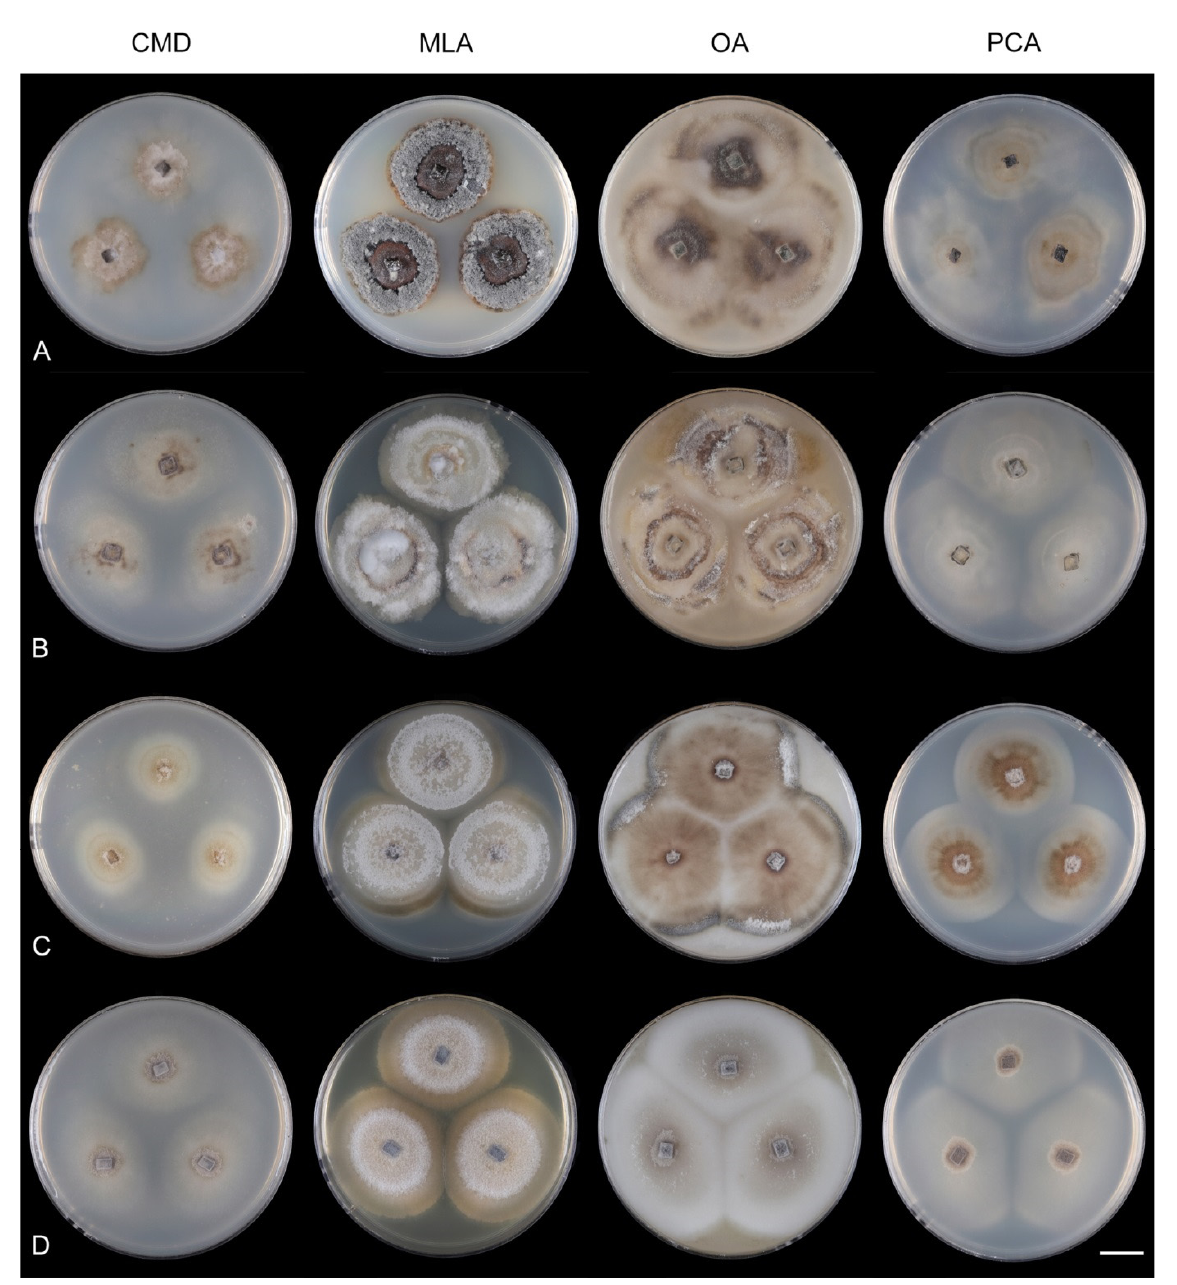
Figure 22. Colony morphology of Codinaeella spp. after 4 weeks. ( A ) Ca. filamentosa CBS 147265 ( B ) Ca. lambertiae CBS 143419 ex-type ( C ) Ca. mimusopis CBS 143435 ex-type ( D ) Ca. pini CBS 138866 ex-type. Scale bar: ( A – D ) 1 cm. Culture characteristics: On CMD: colonies 35–38 mm diam, circular, flat, margin entire, velvety, later mucoid and smooth, whitish-brown, beige toward the margin, reverse beige with a dark brown zone. On MLA: colonies 25–27 mm diam, circular, flat, raised margin, margin entire to weakly undulate, mucoid-waxy to cobwebby, lanose at the margin, colony centre dark burgundy-brown, whitish-grey to grey at the margin with a dark ochre outer zone, dark burgundy (centre) and pale ochre pigment (margin) diffusing into agar, reverse dark burgundy to black. On OA: colonies 50–53 mm diam, circular, flat, slightly raised, margin entire, mucoid, velvety to cobwebby centrally and at the margin, zonate, irregularly dark brown at the centre with beige zones of sparse growth, reverse brown. On PCA: colonies 40–42 mm diam, circular, flat, margin entire, cobwebby, slightly